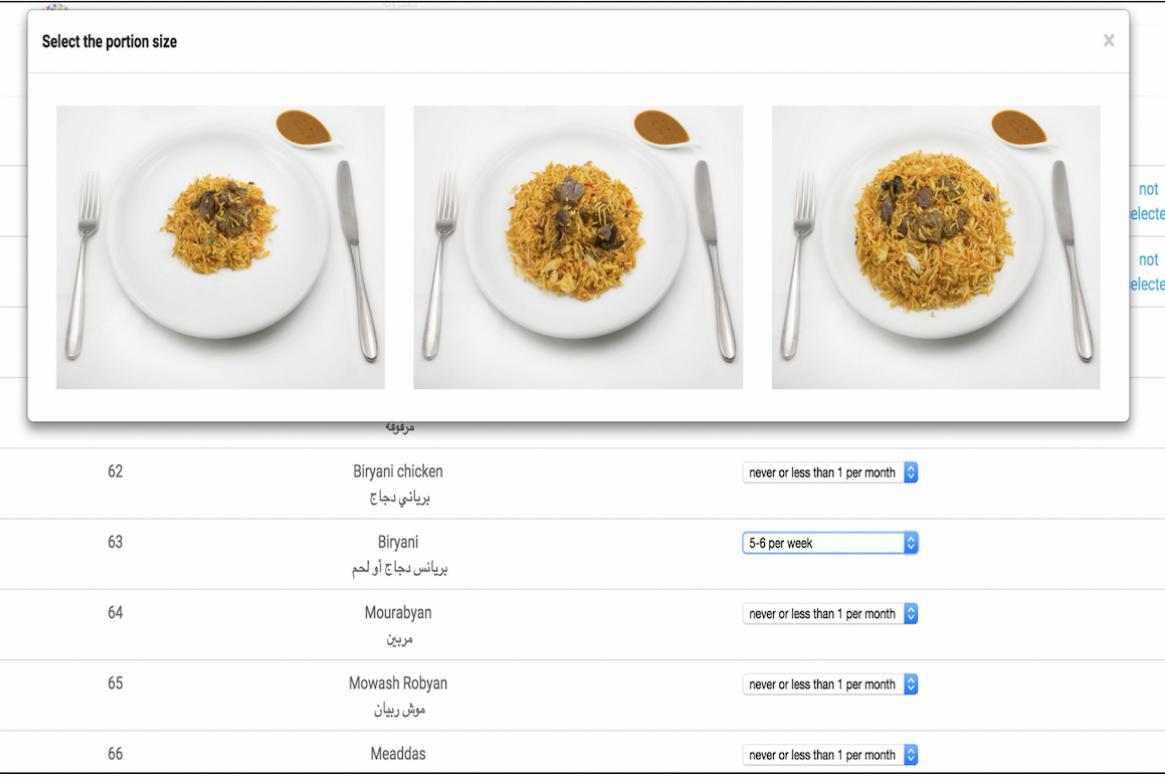
Figure 1. Screenshot of the web-based EatWellQ8 food frequency questionnaire illustrating the 3 portion size photographs for the assessment of the portion